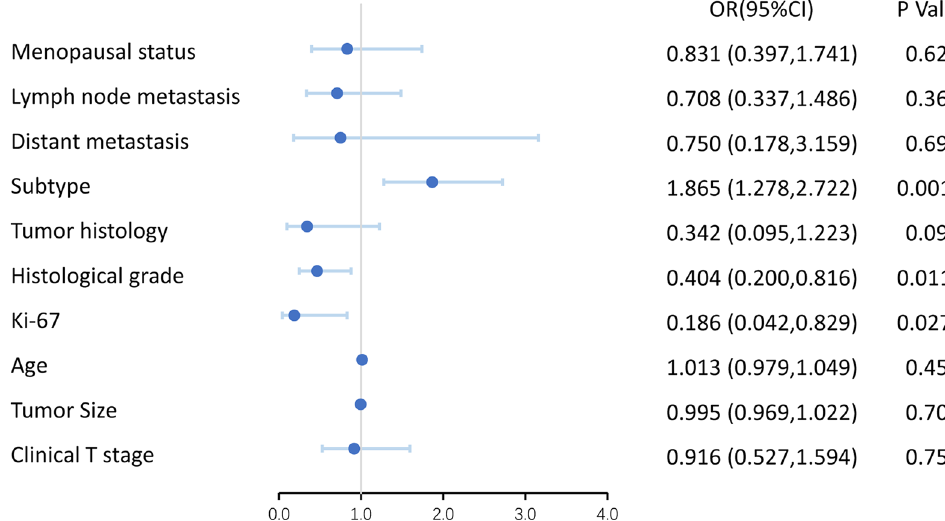
Fig. 2 Forest map of univariate logistic regression analysis based on clinicopathological features related to AR. OR , odds ratio; CI , confidence interval; AR , androgen receptor; * indicates p <